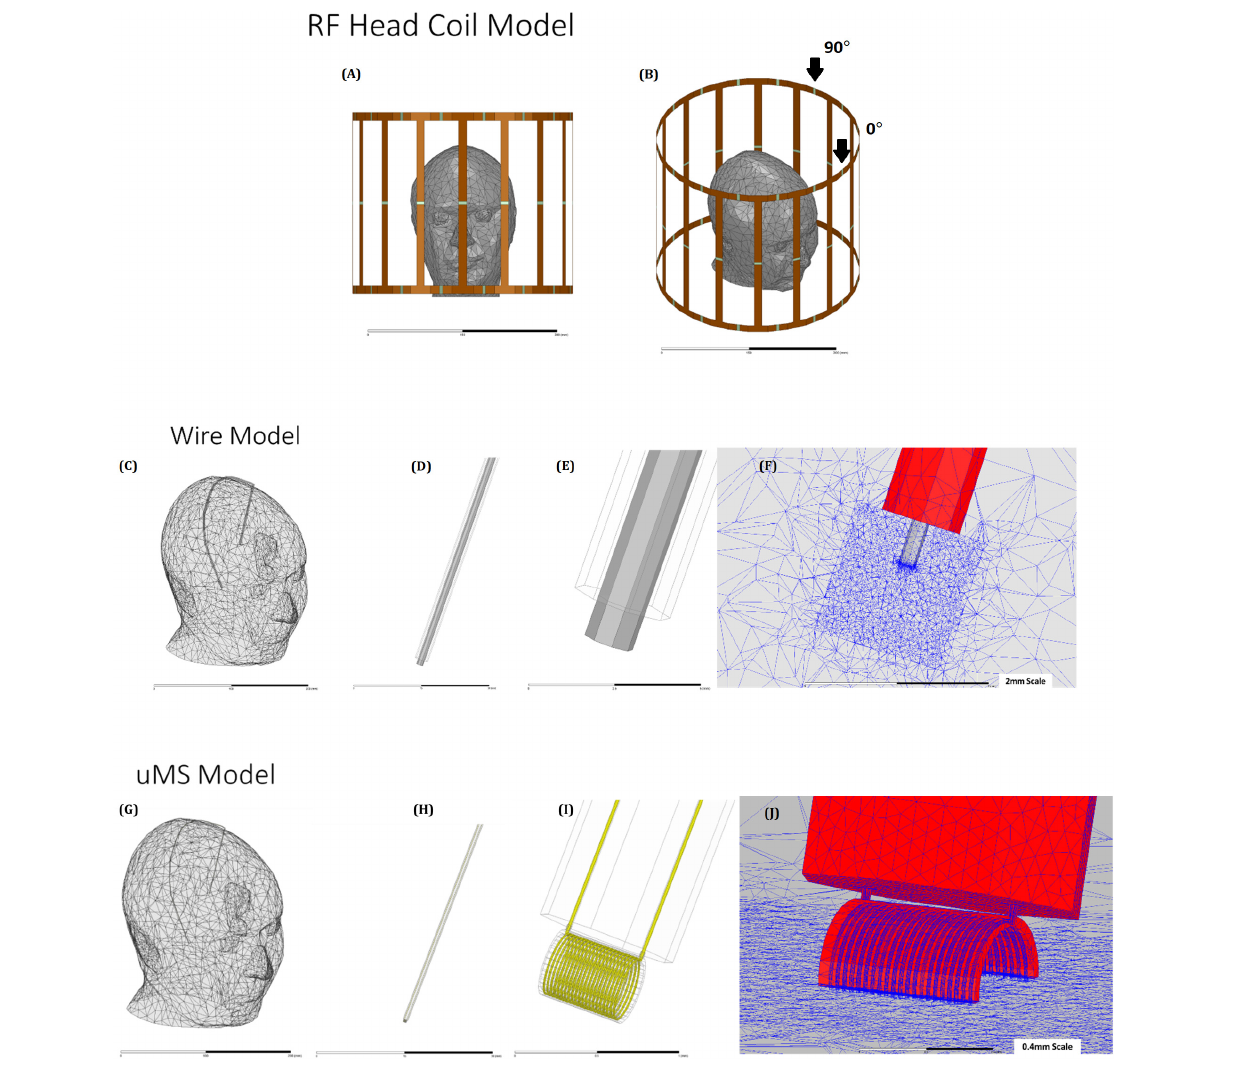
FIGURE 3 | The geometrical model: (A) and (B) head model (Plow et al., 2009) placed in a 1.5 T shielded birdcage coil. (C) Wire implant in the head model, showing outer insulation (D) , exposed wire tip (E) , and details of the mesh (F) head model (G) with the leads (H) , µ MS coil (I) , and details of the mesh (J)